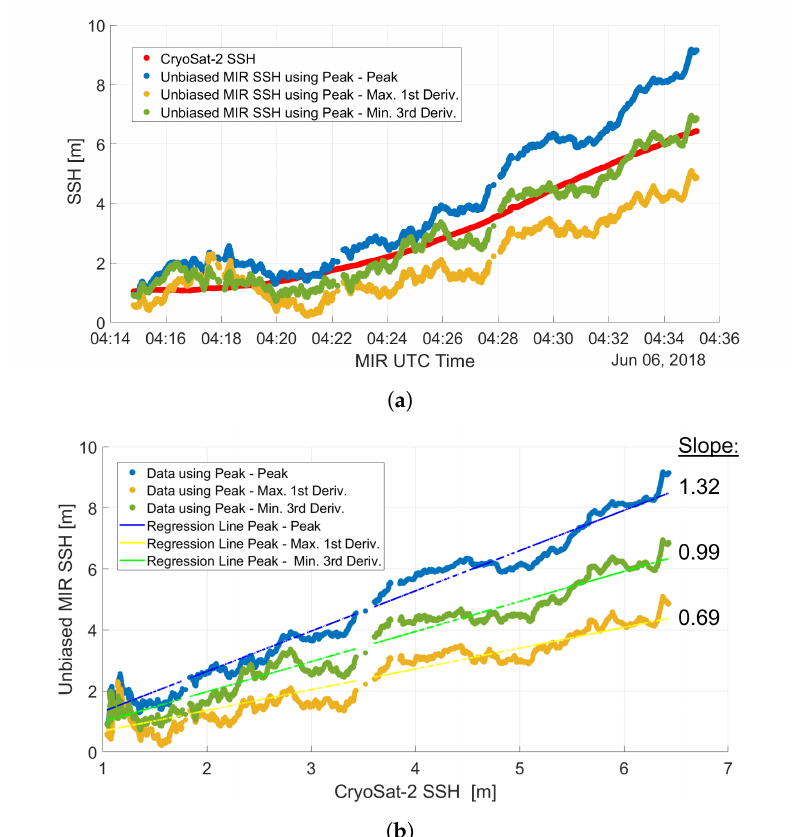
Figure 11. Sample of altimetry estimates computed using cGNSS-R at L1 with 3 different methods: P-P, P-Max1D, and P-Min3D, showing ( a ) the error introduced in the time series, and ( b ) the scatter plot of the unbiased SSH obtained by each method and CryoSat-2 SSH values. Computed using the cGNSS-R technique with T coh = 1 ms and T incoh = 100 s. For this case, P-HP would present similar behaviorthan P-Max1D but with an even lower slope as shown in Table